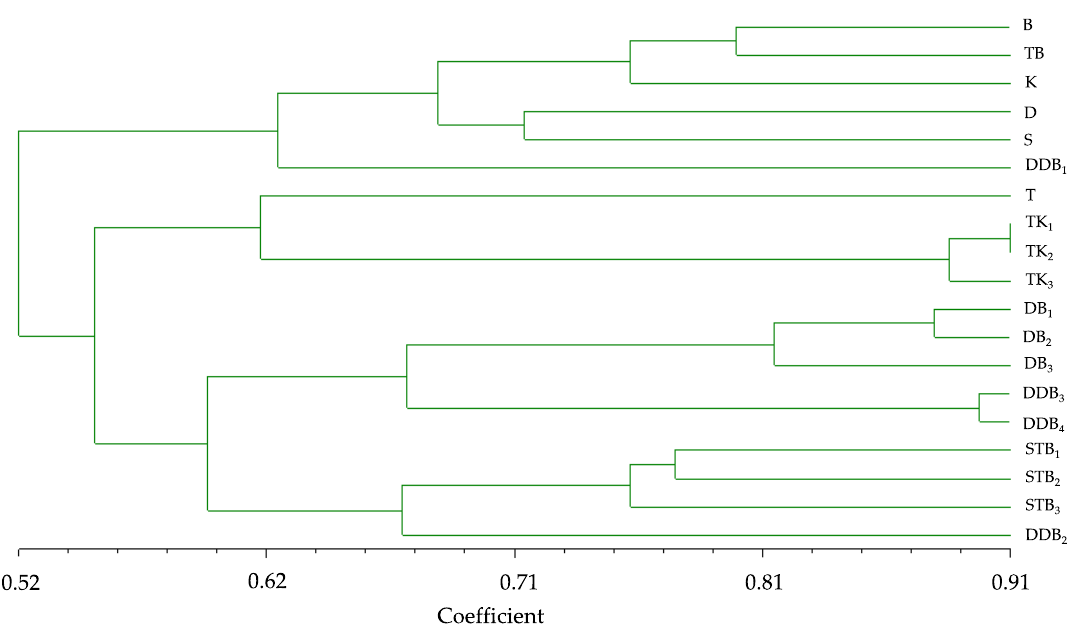
Figure 3. Cluster diagram of rice mutants and their origins. Table 5. Genetic similarity of rice mutants and their